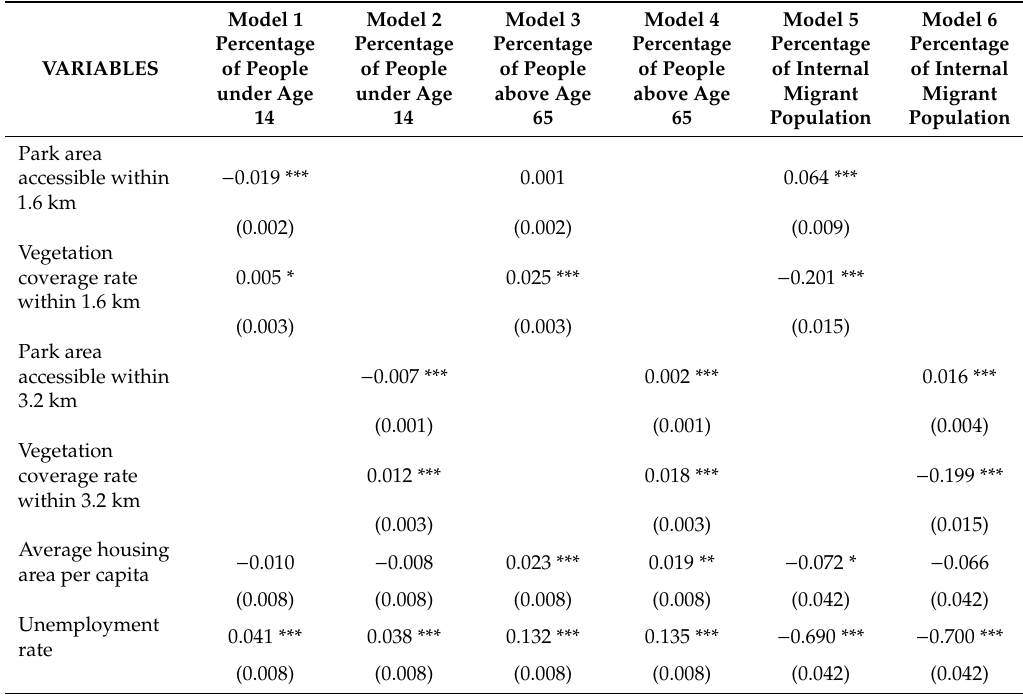
Table A1. Sensitive analysis: regression for entire country using townships with population density larger than 1000 per km 2